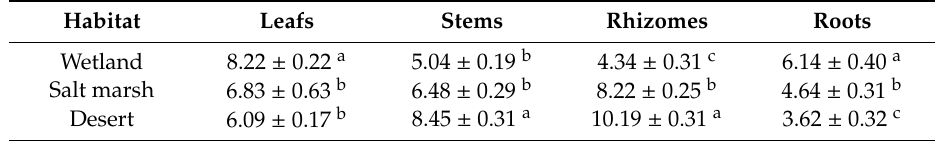
Table 2. Comparison of soluble sugar content in clonal modules of Phragmites communis in different habitats.